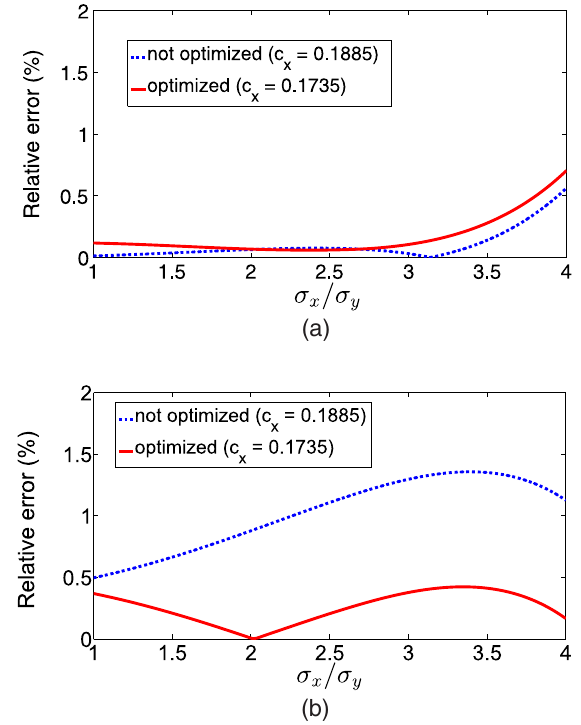
FIG. 7. Relative error of the calculated values of ð σ 2 x − σ 2 y Þ =d 2 as a function of σ x = σ y , σ y =d ¼ 0 . 075 : (a) ¯ x=d ¼ 0 . 05 , ¯ y ¼ 0 ; (b) ¯ x=d ¼ 0 . 125 , ¯ y ¼ 0